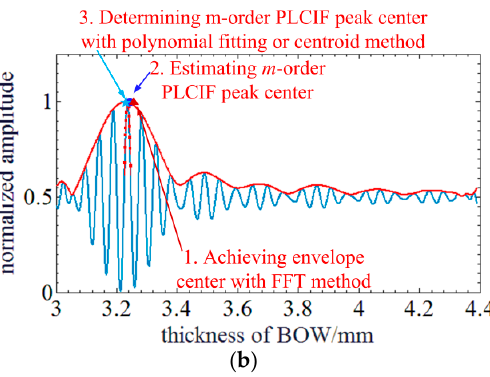
Figure 7. Summary of the proposed MADM method: ( a ) Processing flow of the proposed MADM method; ( b ) Schematic of the PLCIF processing flow.